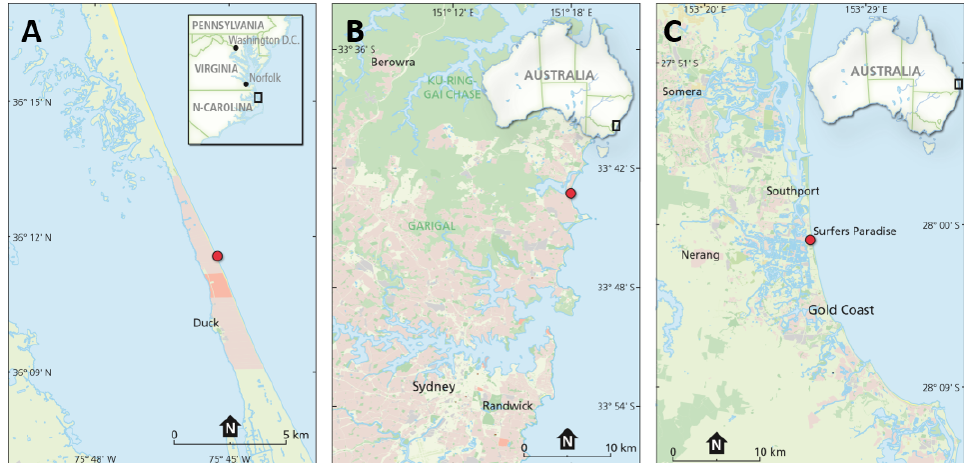
Figure 2. The location of the three field sites, ( A ): Duck (US), ( B ): Narrabeen (Australia) and ( C ): Gold Coast (Australia).